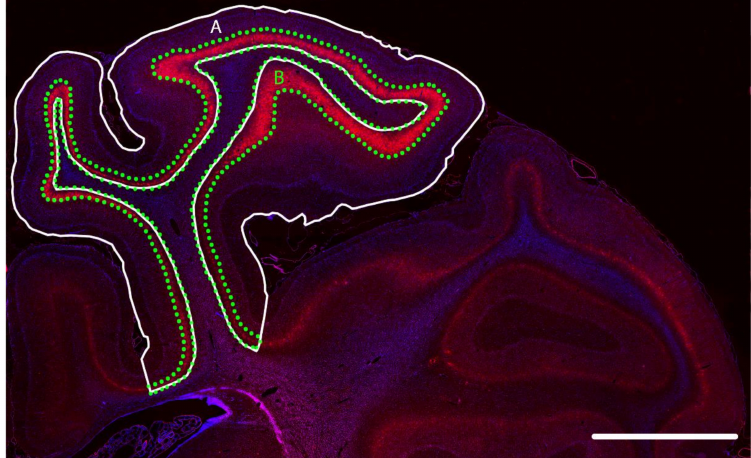
Figure 5. Sampling regions in the right parasagittal cortex of the near-term fetal sheep brain: Representative regions of interest for tracing ( A ) all layers of the cortices of the first two parasagittal gyri at the level of the mid-striatum (solid line) and ( B ) the dense Wisteria floribunda agglutinin (WFA; red staining) + layer (layer 6; dotted line). Blue staining, nuclear labelling with Hoechst. Scale bar: 5